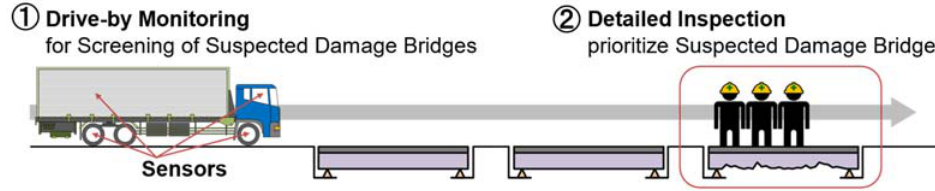
Figure 1. Conceptual diagram of drive-by monitoring.